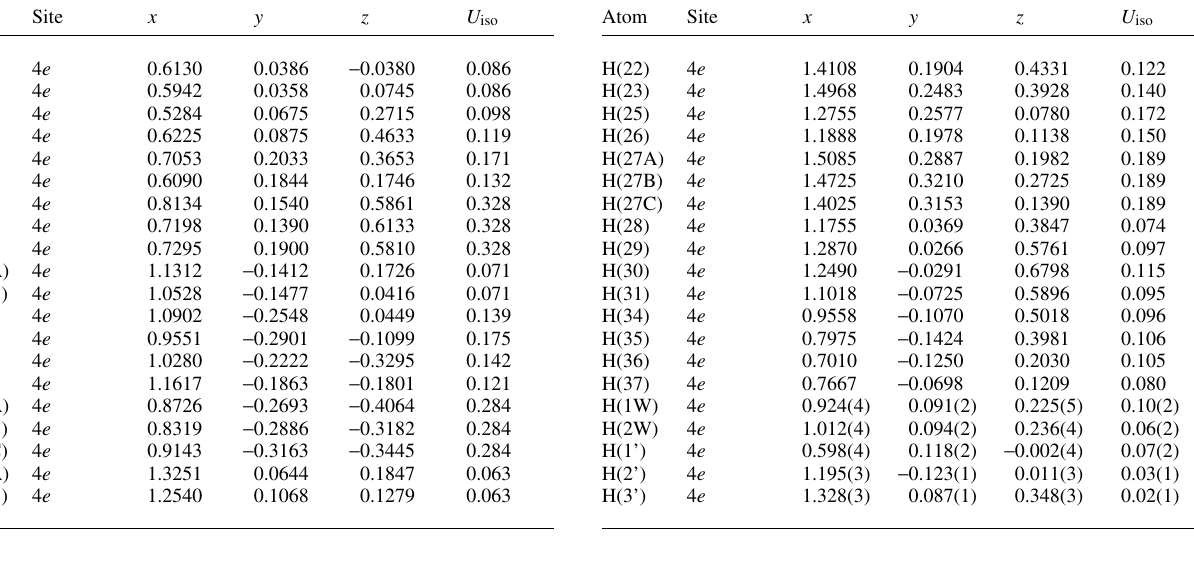
Table 3. Atomic coordinates and displacement parameters (in Å 2 )